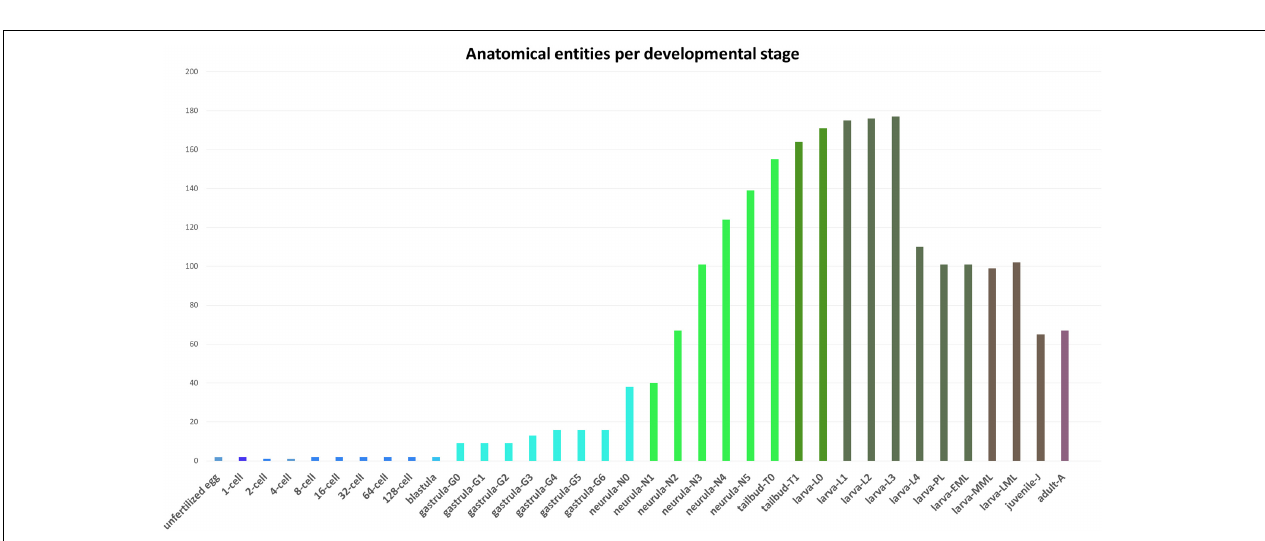
FIGURE 1 | The amphioxus life cycle. The ten developmental periods defined in AMPHX are indicated. Periods between zygote and metamorphosis are planktonic. The juvenile and adult periods are benthic. The size of the Branchiostoma lanceolatum embryos and larvae ranges from 80 to 100 µ m in the zygote and early embryonic stages to several millimeters in the larval stages. Metamorphosis occurs in larvae with sizes of between 5 and 7 mm. Juveniles range in size from 5–7 mm to 3 cm and adults from 3 to 8 cm. Illustrations from zygote to larva periods have been adapted from Carvalho et al. (2021).